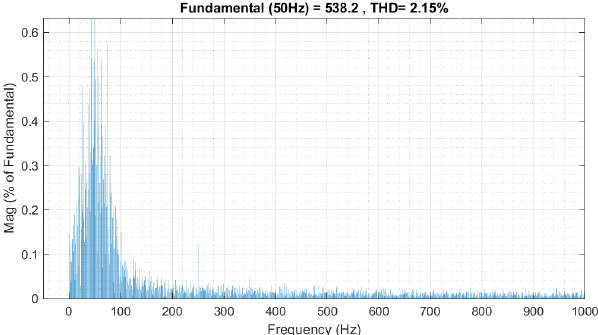
Figure 9. Transformer secondary/rectifier input current total harmonic distortion.